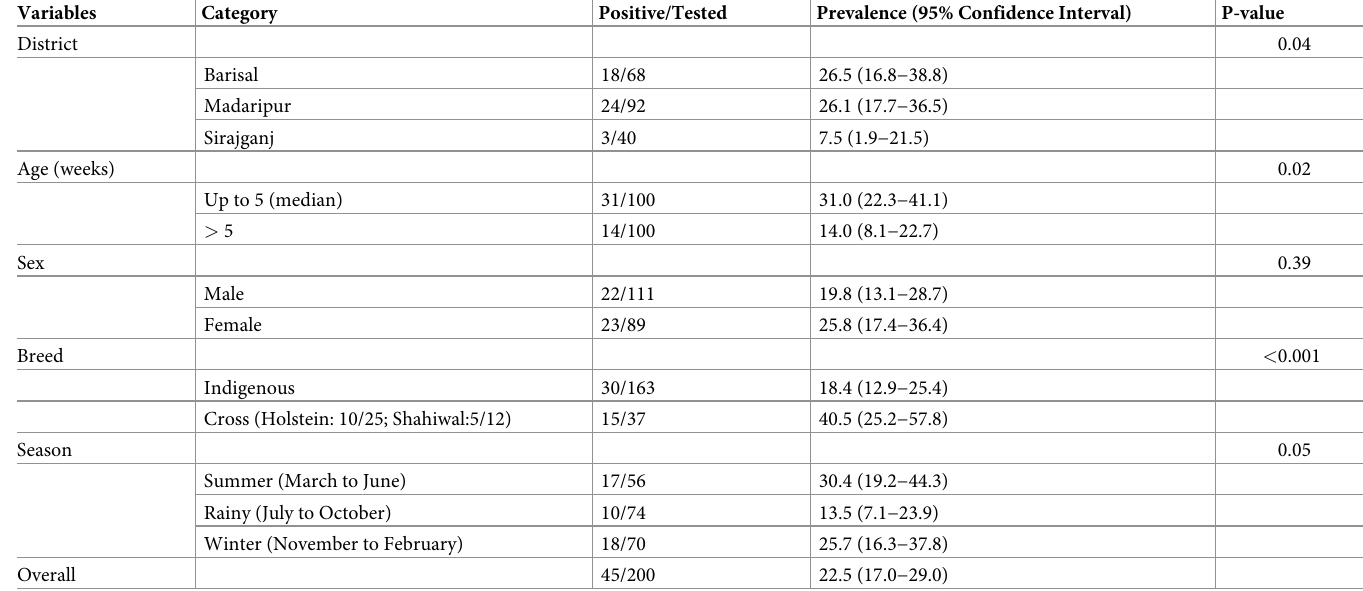
Table 3. Contingency tables and Pearson’s Chi-square test conducted to evaluate the association between explanatory variables and rotavirus diarrhea in calves in Barisal, Madaripur and Sirajganj districts in Bangladesh, 2014 − 2015.